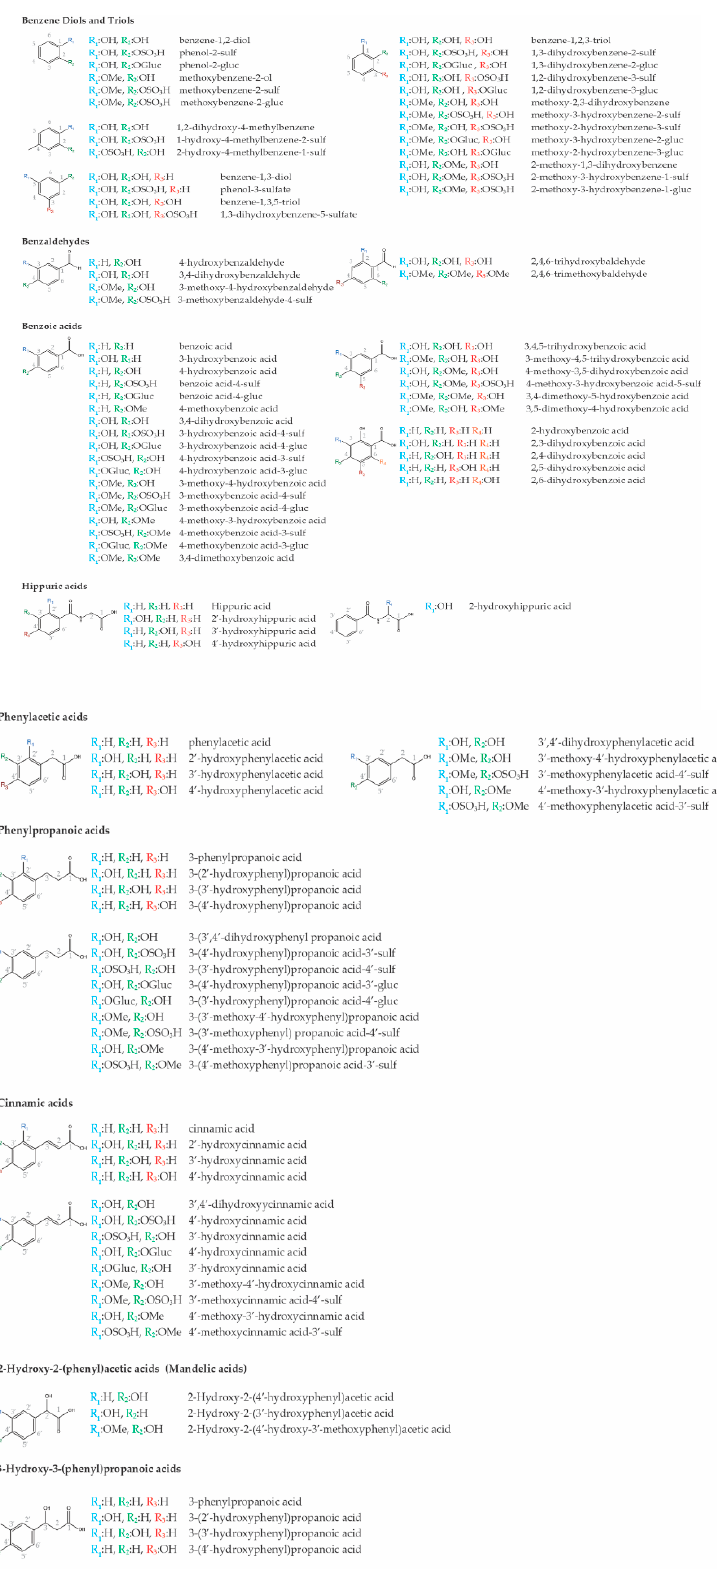
Figure 2. Chemical structures of low molecular weight (poly)phenol metabolites resulting from gut microbiota catabolism of flavonoids or enterohepatic phase I and II metabolic conversions. The nomenclature used followed recent recommendations [32]. Sulf—sulfate; Gluc—glucuronide; Me—methyl group.